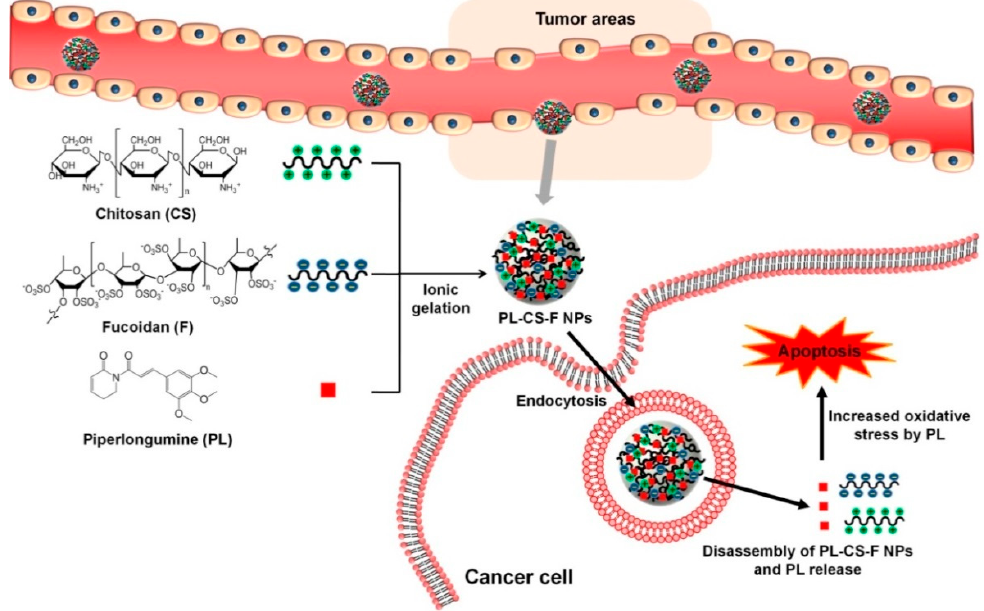
Figure 1. Schematic illustration showing the fabrication of piperlongumine-loaded chitosan–fucoidan nanoparticles (PL-CS–F NPs) and their working mechanisms for apoptosis in cancer cells.